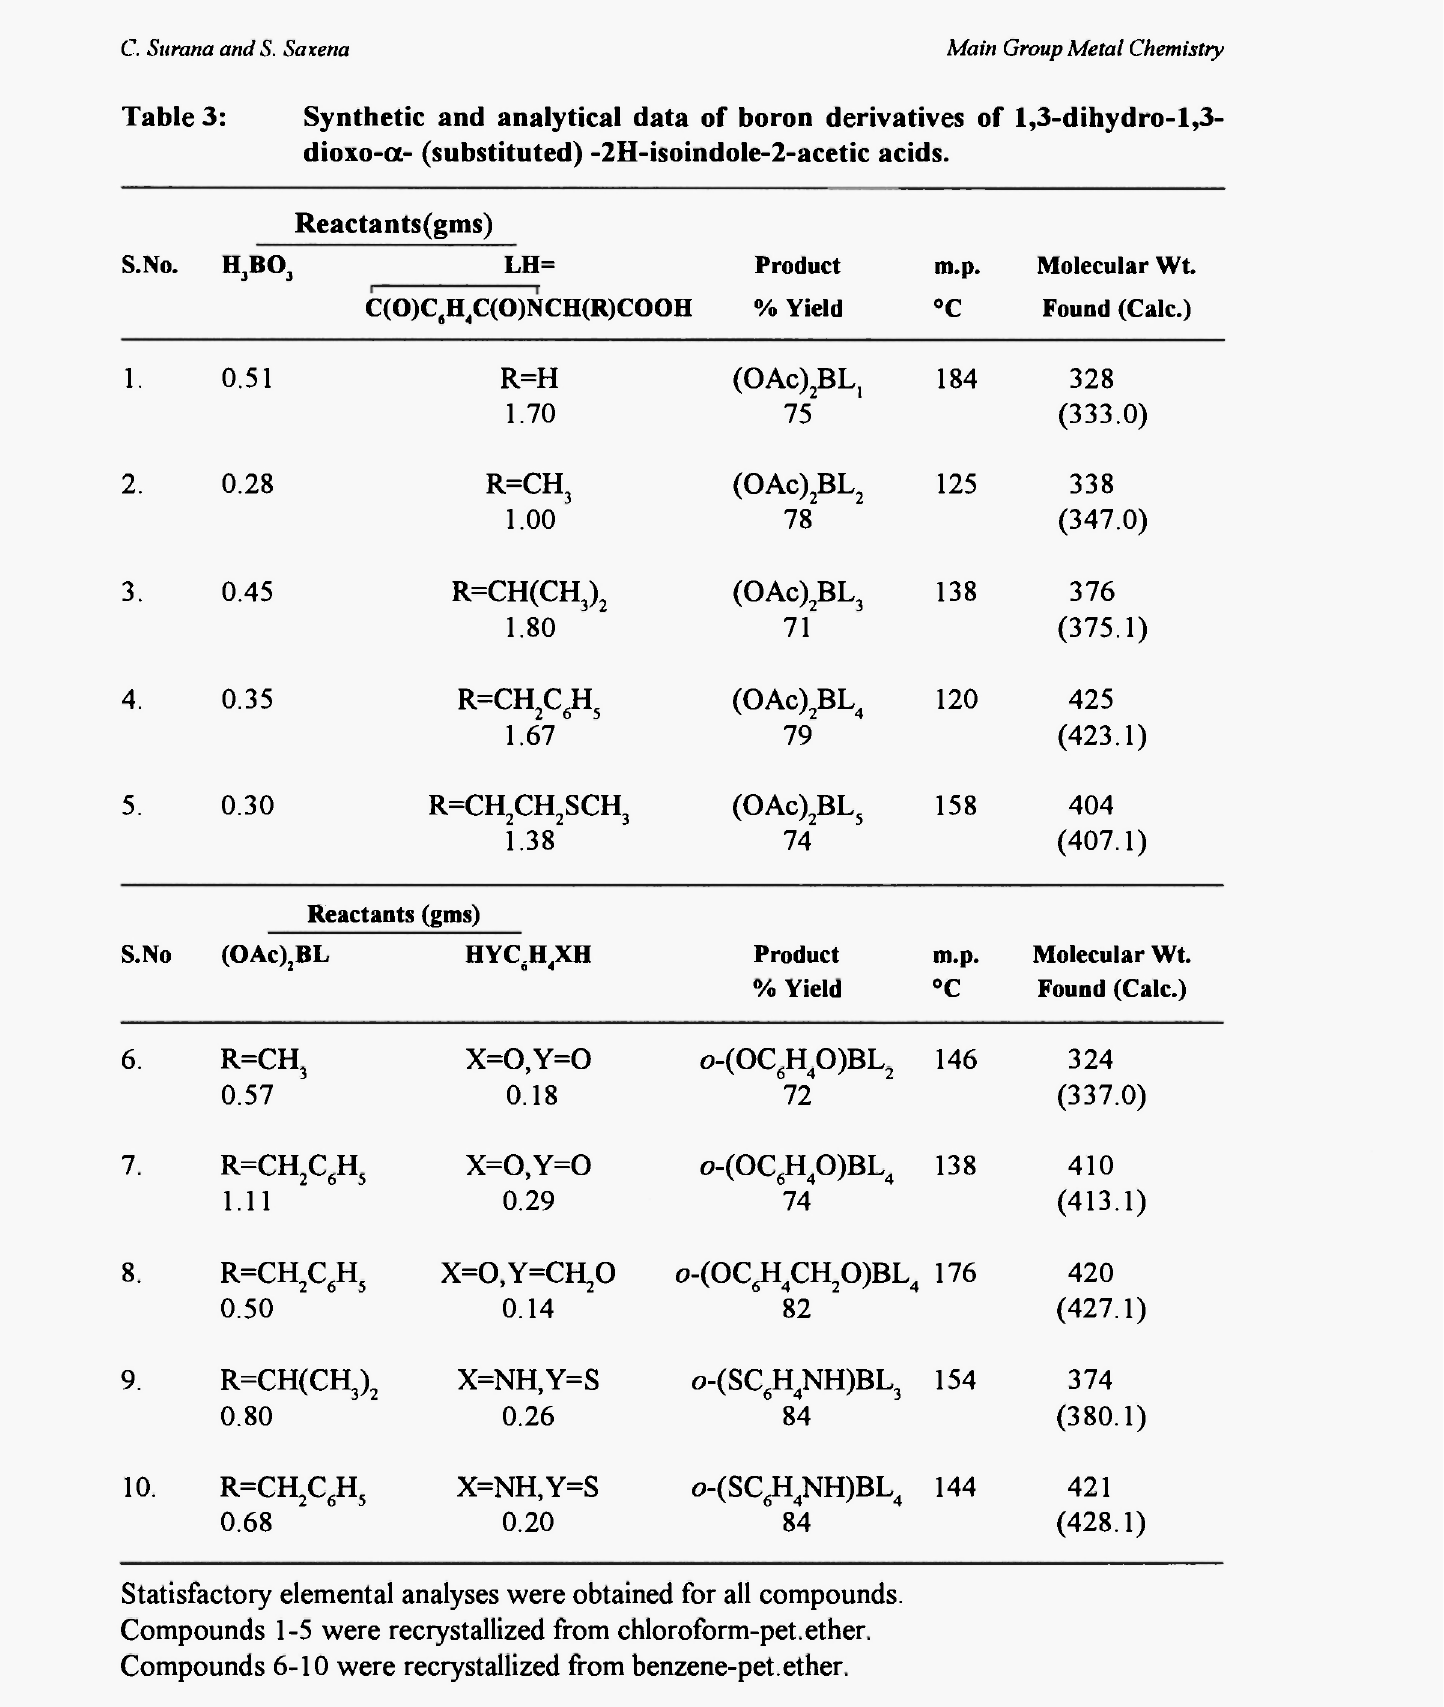
Synthetic and analytical data of boron derivatives of l,3-dihydro-l,3- dioxo-α- (substituted) -2H-isoindole-2-acetic acids.